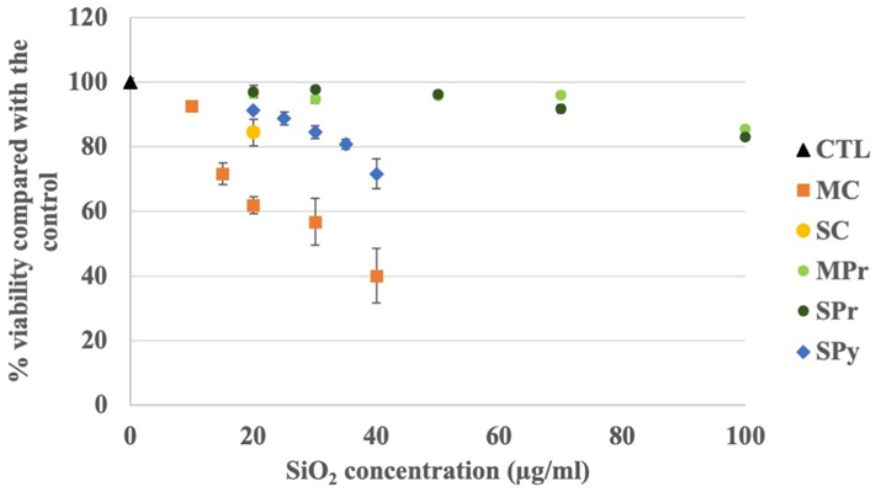
Figure 2. Viability assays of SAS exposure (24 h), on J774A.1 macrophages. Precipitated silicas are in green, colloidal silicas in orange, and the pyrogenic SAS in blue. Round dots are for small particle SAS and square dots for medium particle SAS; CTL: control, untreated cells; MC: medium-particle colloidal silica; SC: small-particle colloidal silica; SPr: precipitated silica with small primary particles; MPr: precipitated silica with medium-size primary particles; SPy: pyrogenic silica with small primary particles. The lethal doses 20 were estimated at 15 µg/mL for MC, 20 µg/mL for SC, 100 µg/mL for SPr and MPr, and 35 µg/mL for SPy.